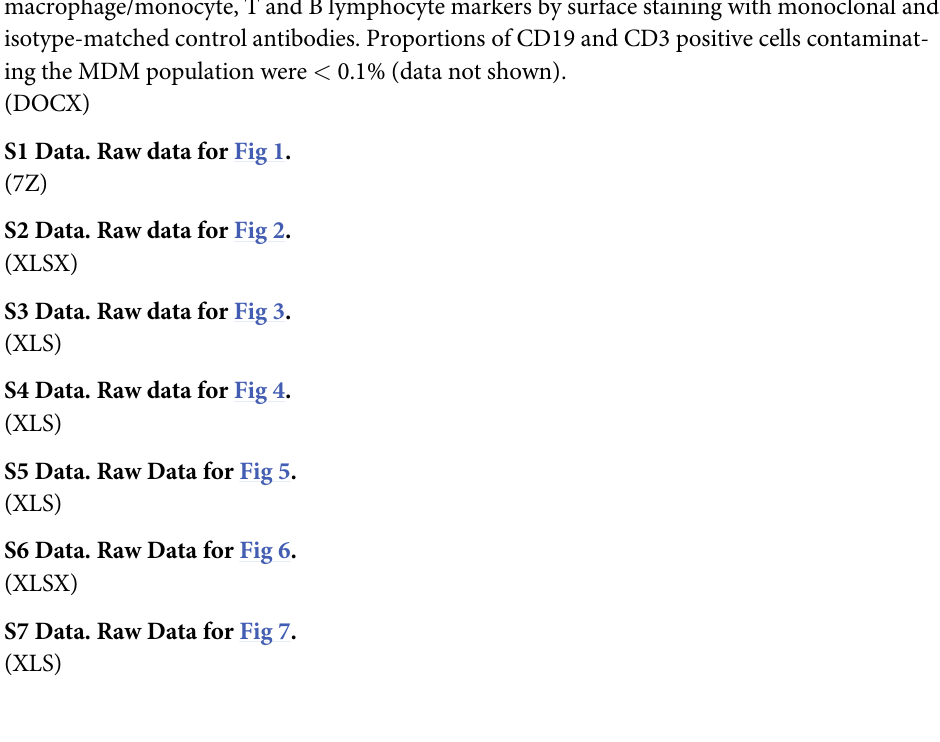
S1 Table. Phenotypic characterization of human MDM. Expression of macrophage surface markers on MDM used in this study was characterized by flow cytometry. Percent positive MDM obtained from adherent monocytes after 7-days of differentiation were evaluated for macrophage/monocyte, T and B lymphocyte markers by surface staining with monoclonal and isotype-matched control antibodies. Proportions of CD19 and CD3 positive cells contaminat- ing the MDM population were < 0.1% (data not